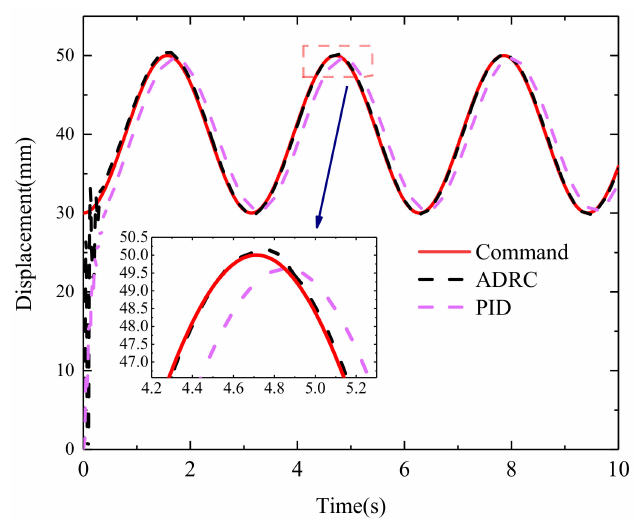
Figure 18. Responses to constant